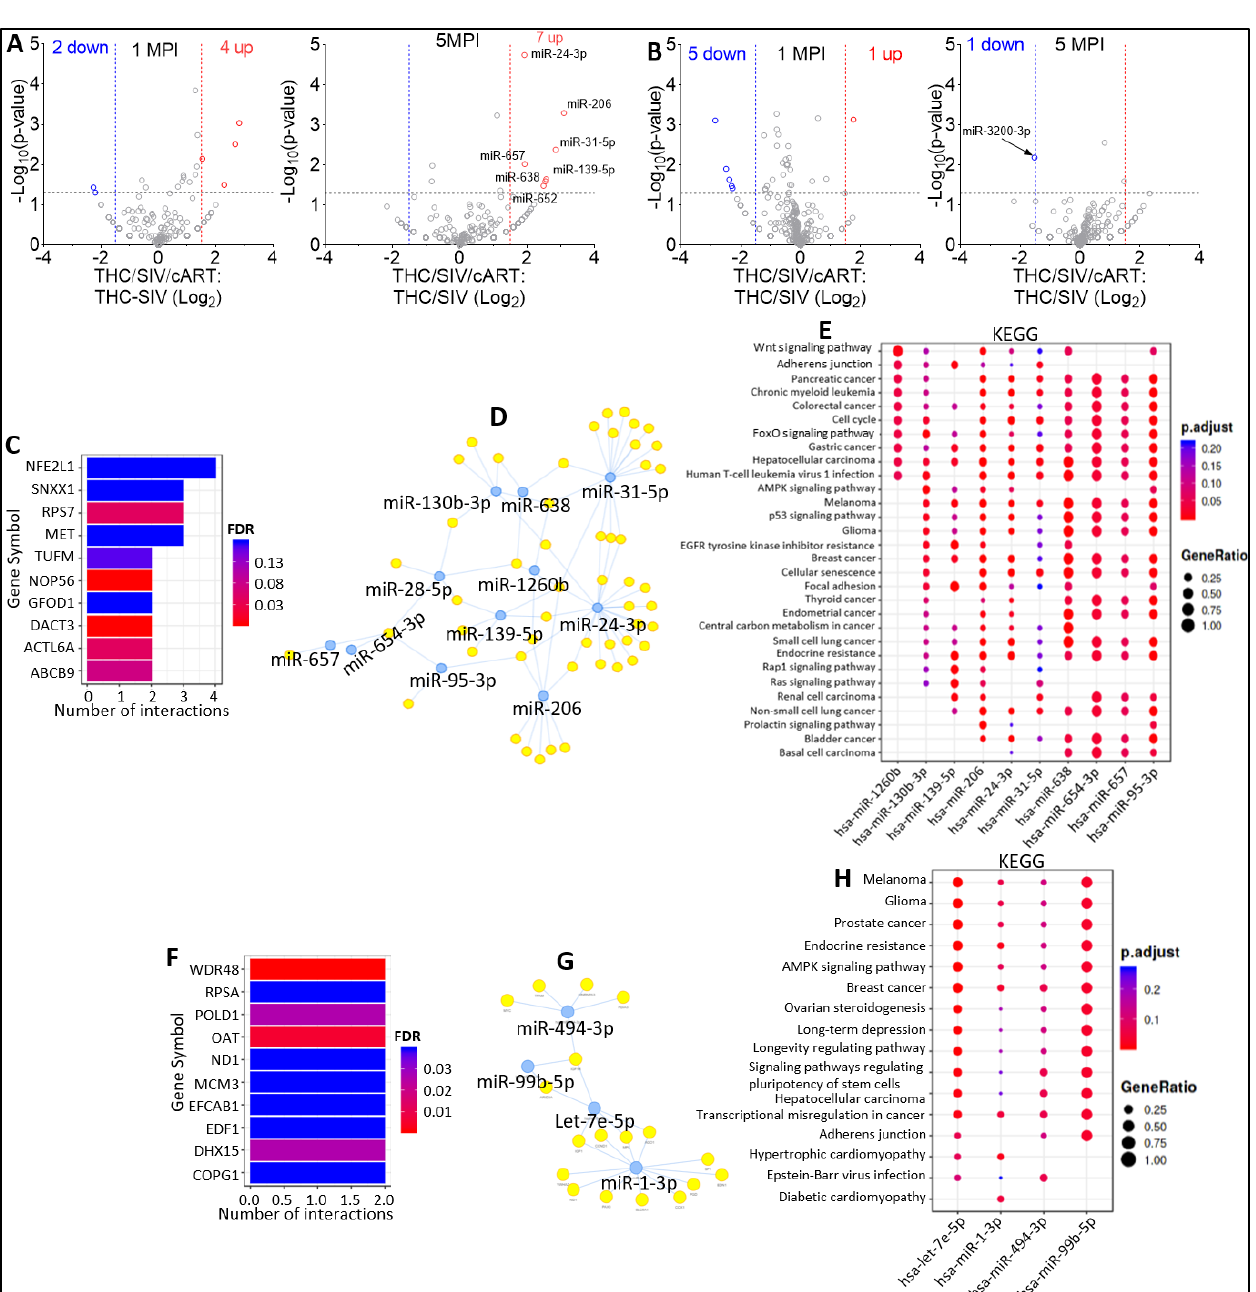
Figure 6. Alterations in miRNA profile of THC-treated, SIV-infected, cART-treated RMs. ( A ) Volcano plot showing down-(blue) regulated and up-(red) regulated miRNAs in THC/SIV/ART EVs relative to THC/SIV EVs at 1 MPI (left) and 5 MPI (right). ( B ) Volcano plot showing down-(blue) regulated and miRNAs in THC/SIV/ART ECs relative to THC/SIV ECs at 1 MPI (left) and 5 MPI (right). ( C ) miRNA-target enrichment analysis showing top target genes by number of interactions for the 13 significantly modulated EV-associated miRNAs (miR-130b-3p, miR-654-3p, miR-28-5p, miR-95-3p, miR-144, miR-1260b, miR-24-3p, miR-206, miR-31-5p, miR-657, miR-139-5p, miR-638, miR-652) at 1 MPI and 5 MPI. ( D ) Visualization of miRNA-target interaction network for the 13 significantly modulated EV-associated miRNAs. The blue circles represent the miRNAs, while the target genes are represented by the yellow circles. Pathways are represented by blue lines. ( E ) Dot plot of functional enrichment analysis for the 13 significantly modulated EV miRNAs. Color of dots